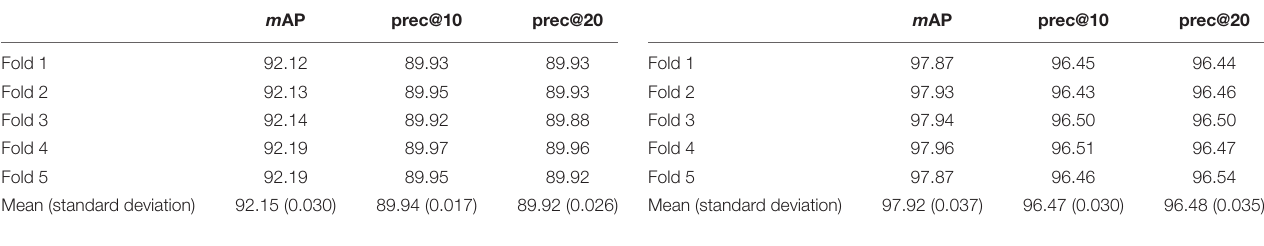
TABLE 1 | Retrieval performance of SRDML for the query image Meningioma on 5-fold test set.